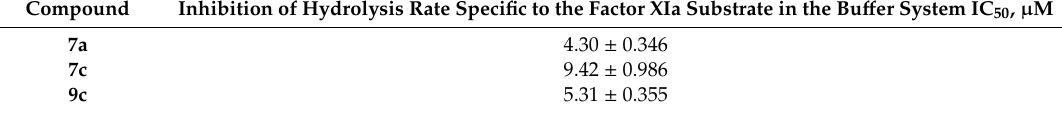
Table 2. Results of the experimental measurements of the IC 50 values of factor XIa inhibition for various